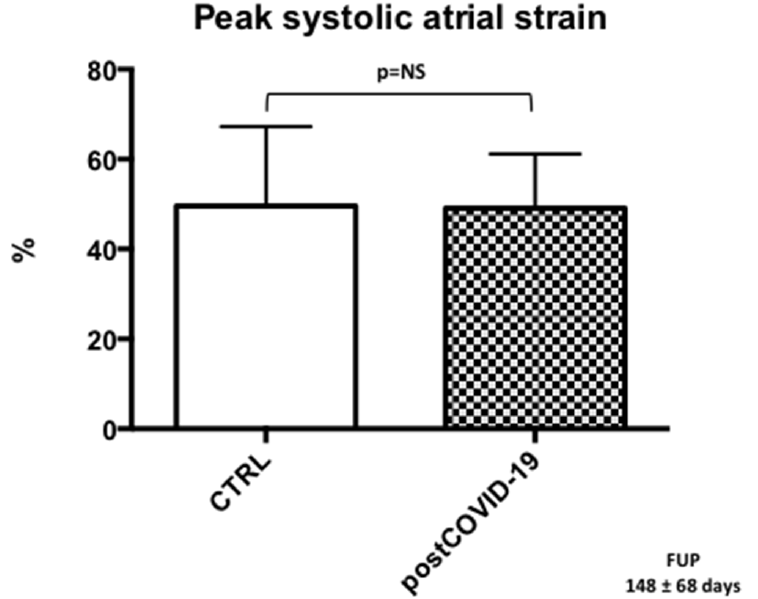
Figure 4. Peak systolic left atrial strain in the post-COVID-19 group compared with CTRL. Reproducibility analysis. Indices of intra- and inter-observer variability were very good for longitudinal strains (7 ± 7%, ICC: 0.92 and 7 ± 8%, ICC: 0.9,